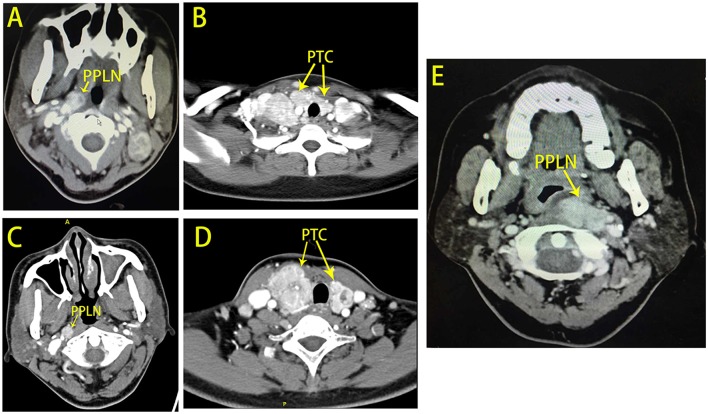
Computed tomography (CT) scans for patients with PPLN metastases. (A,B) Show patient No. 3 with bilateral papillary thyroid carcinoma with right PPLN metastases. (C,D) Show patient No. 4 with bilateral papillary thyroid carcinoma with right PPLN metastases. (E) Shows patient No. 5 with left PPLN recurrence 17 years after the first surgery.